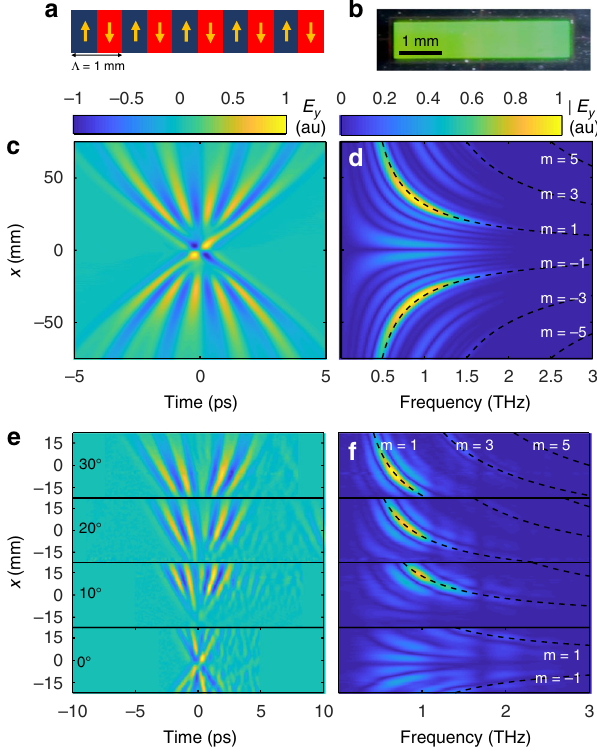
Fig. 4 Terahertz generation from nonlinear metamaterial photonic crystals (NLMPC). a Structure of the fabricated NLMPC. Arrows indicate the orientation of the split-ring resonators, similarly to Fig. 3a. b Re fl ection image of the fabricated NLMPC. c Simulation of the spatiotemporal pro fi le of the THz emission pattern from the NLMPC in a when excited by the near-infrared pulse at normal incidence. d Frequency domain spatial pro fi le of c . Dashed lines mark the Raman – Nath diffraction orders. e Measured THz emission pattern from NLMPC fabricated according to a , with varying incidence angles, in the time domain and f in the frequency domain. Dashed lines indicate calculated Raman – Nath relation for different diffraction